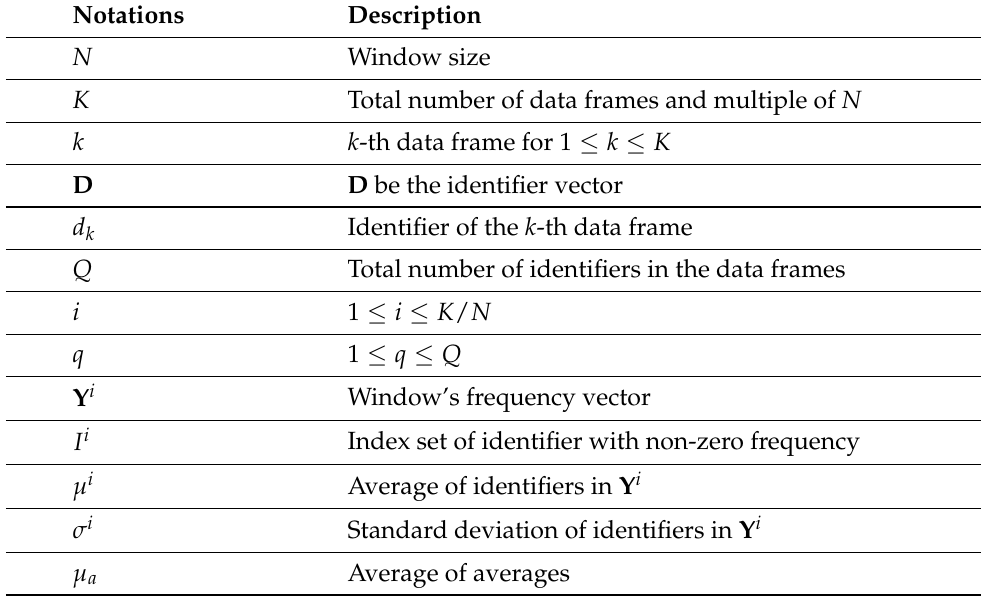
Table 1. List of key